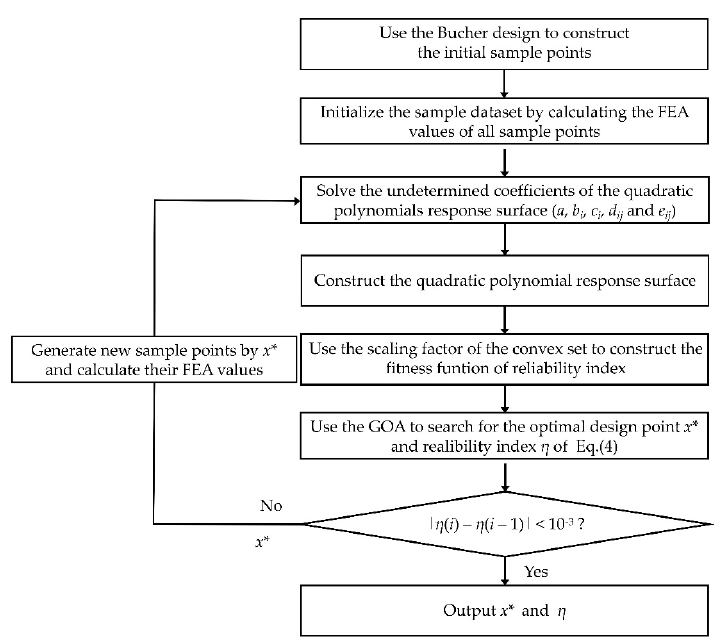
Figure 5. Implementation flowchart of the proposed method.